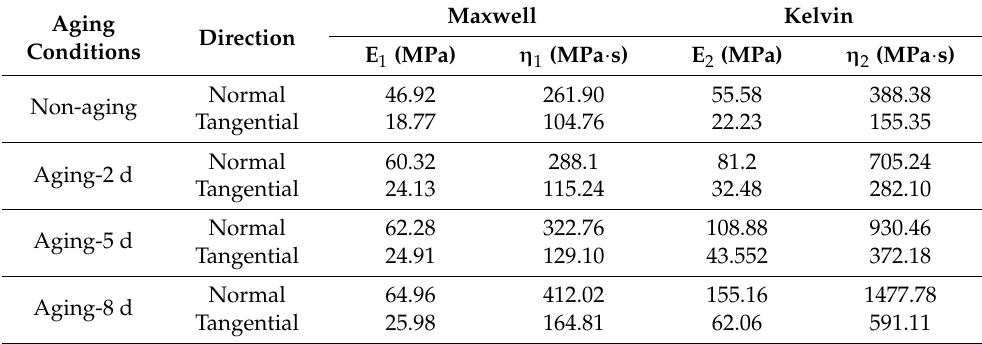
Table 3. Discrete element meso-parameters of the Burgers model under different aging conditions.